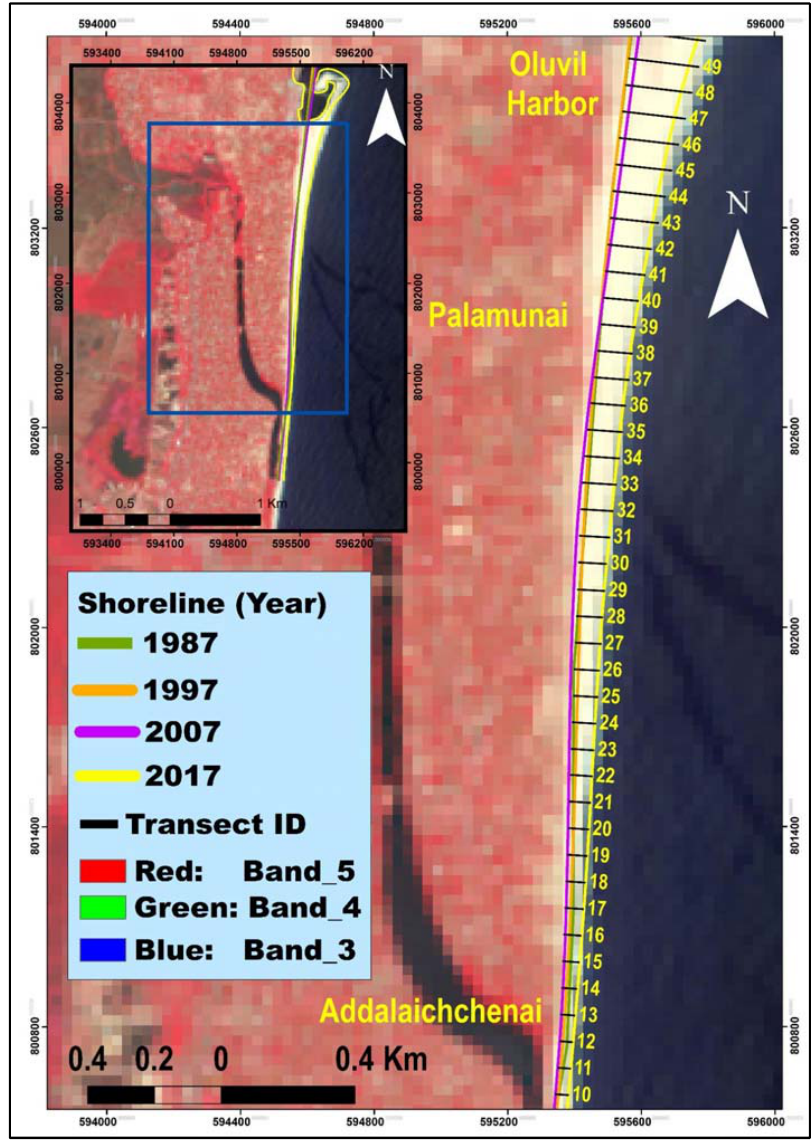
Figure 6. Accretion and shoreline changes southwards of the harbor.